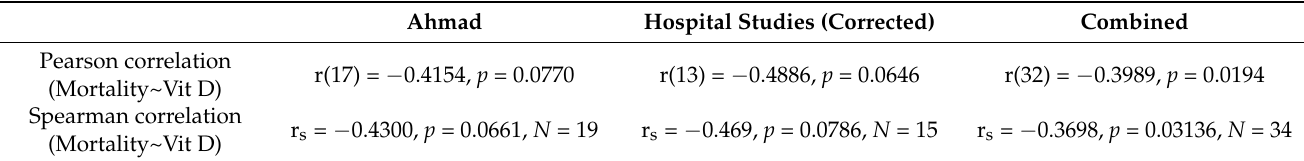
Table 5. OLS regressions for the respective datasets.